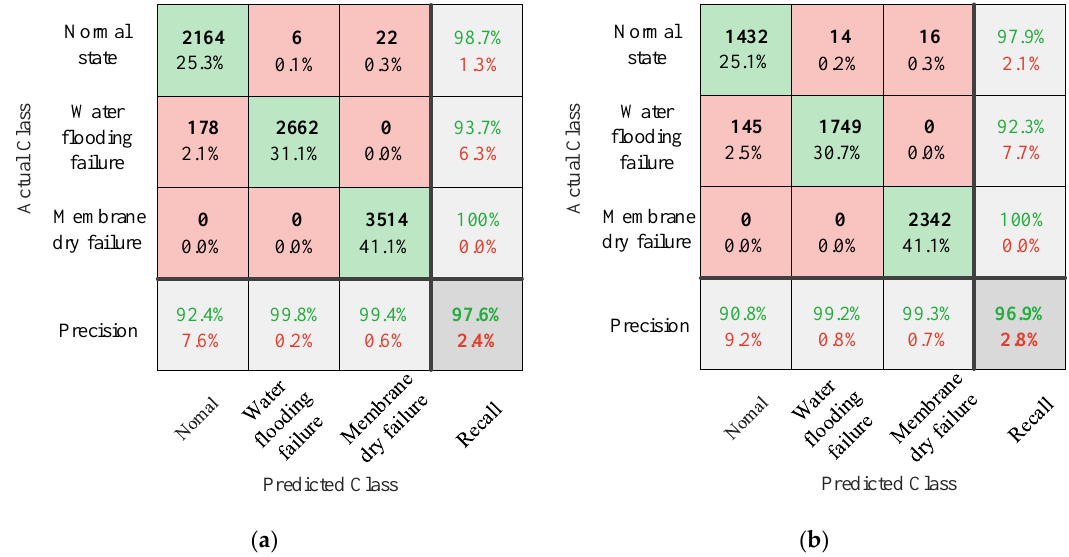
Figure 9. The confusion matrix of KPCA-LVQNN. ( a ) Training confusion matrix; ( b ) test confusion matrix. At the same time, precision and recall rate are used to evaluate the proposed ap- proach effect. Precision rate is defined as the percentage of the number of correct samples